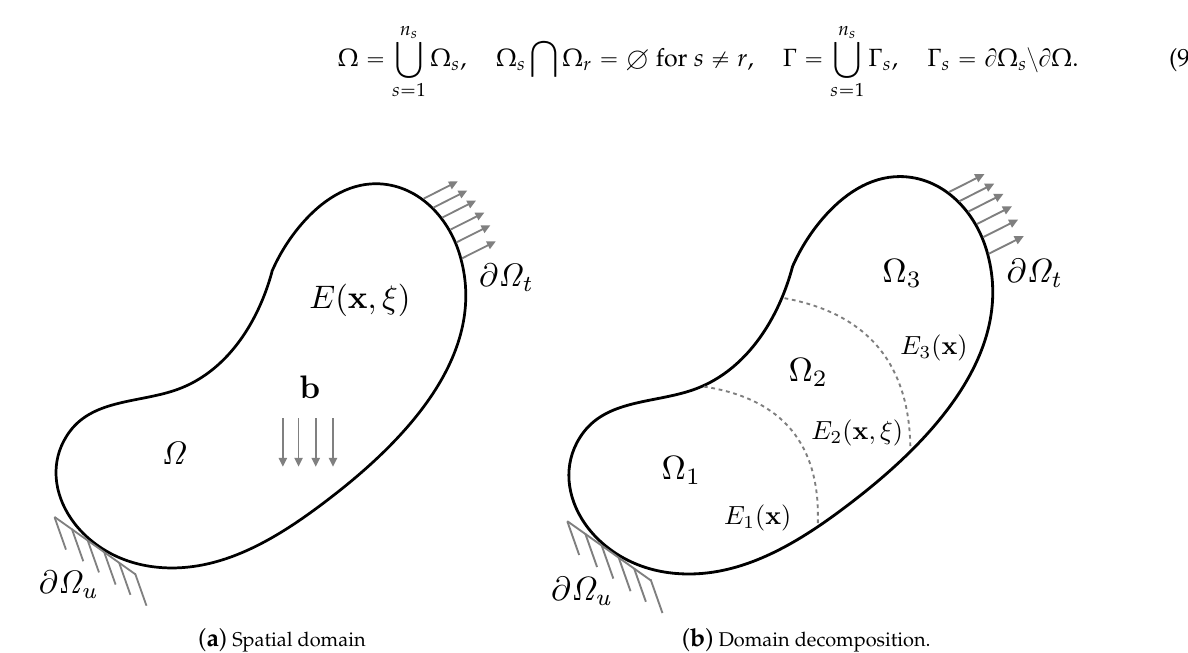
Figure 1. An arbitrary computational domain Ω with a random material property (i.e., E p x , ξ q ) and its partitioning into non-overlapping subdomains. The partitioning is based on material